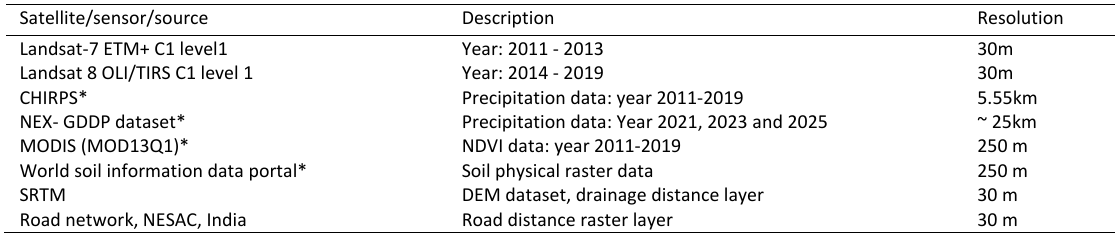
Table 1: Input data and sources